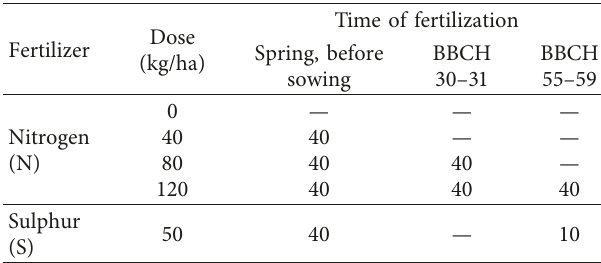
Table 5: The doses and phases of application of nitrogen (N) and sulphur (S)